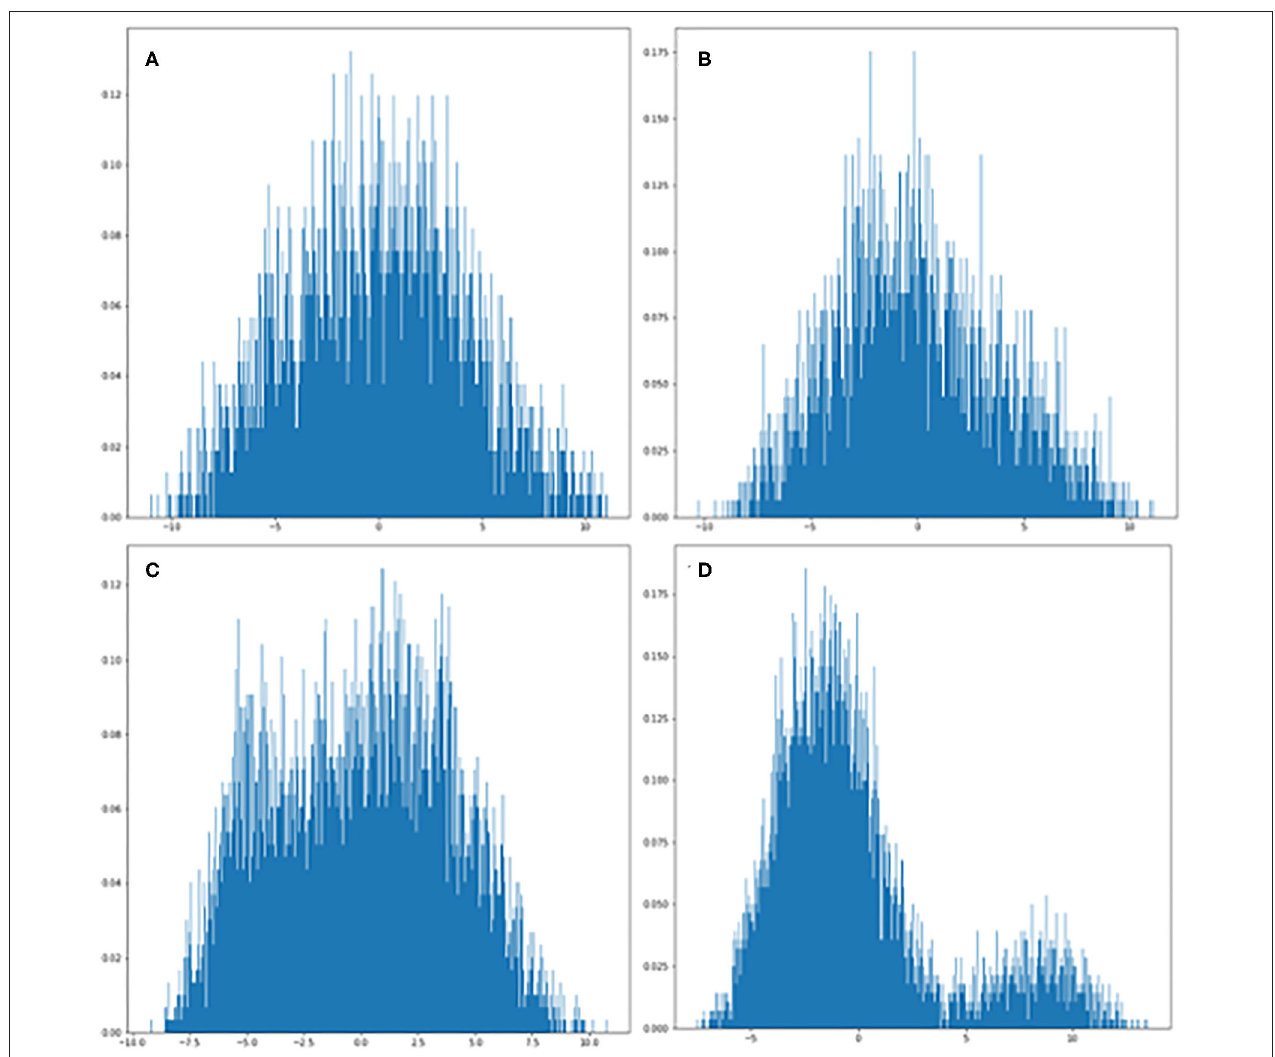
FIGURE 2 | PCA plots of GAN-generated images from each category. (A) Visualization of ischemic scar image set generated from PGGAN. (B) Visualization of control image set generated from PGGAN. (C) Visualization of ischemic scar image set generated from CycleGAN. (D) Visualization of control image set generated from